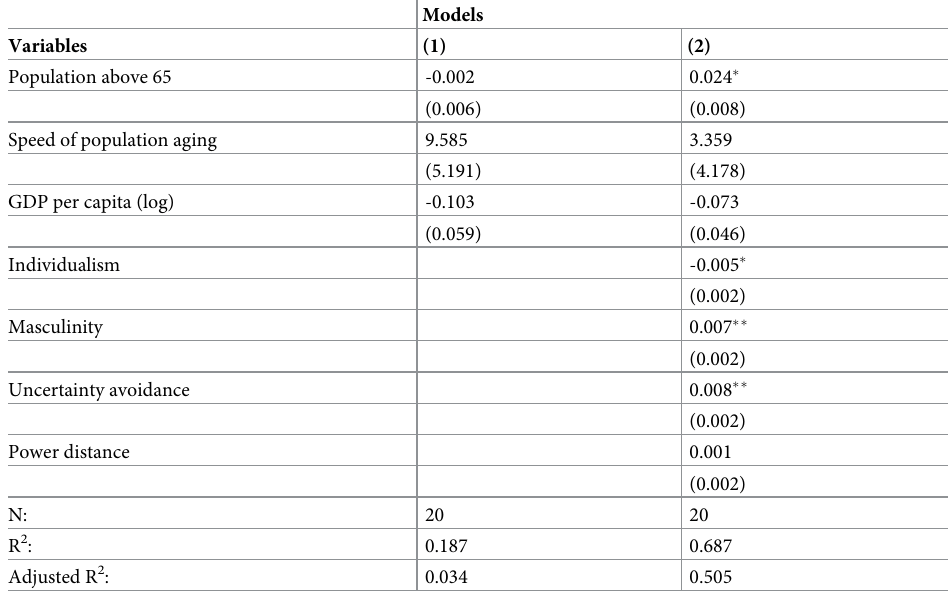
Table 1. Regressions of societal perceptions of caregivers with cultural dimensions and aging